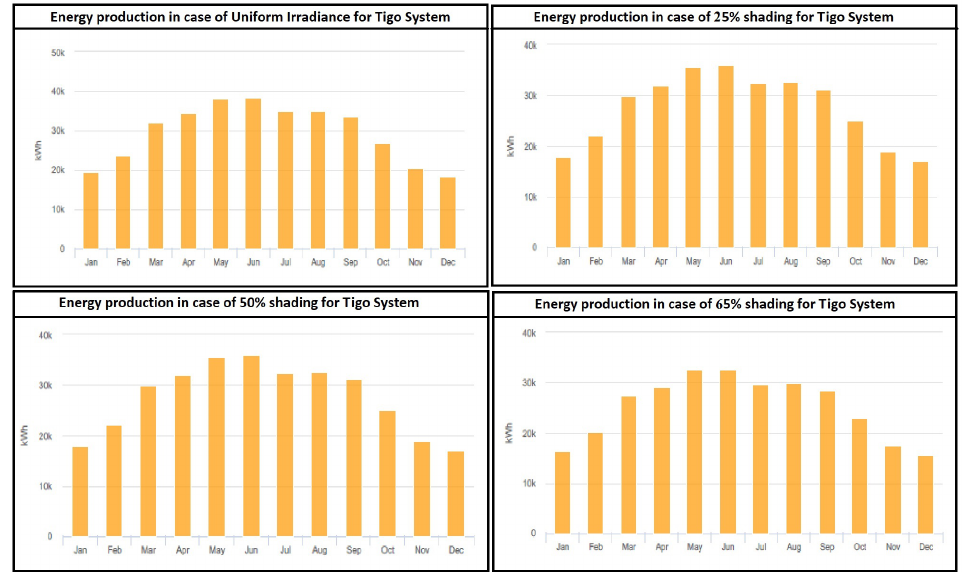
Figure 38. Results of energy production of Tigo solar system on different shading conditions using